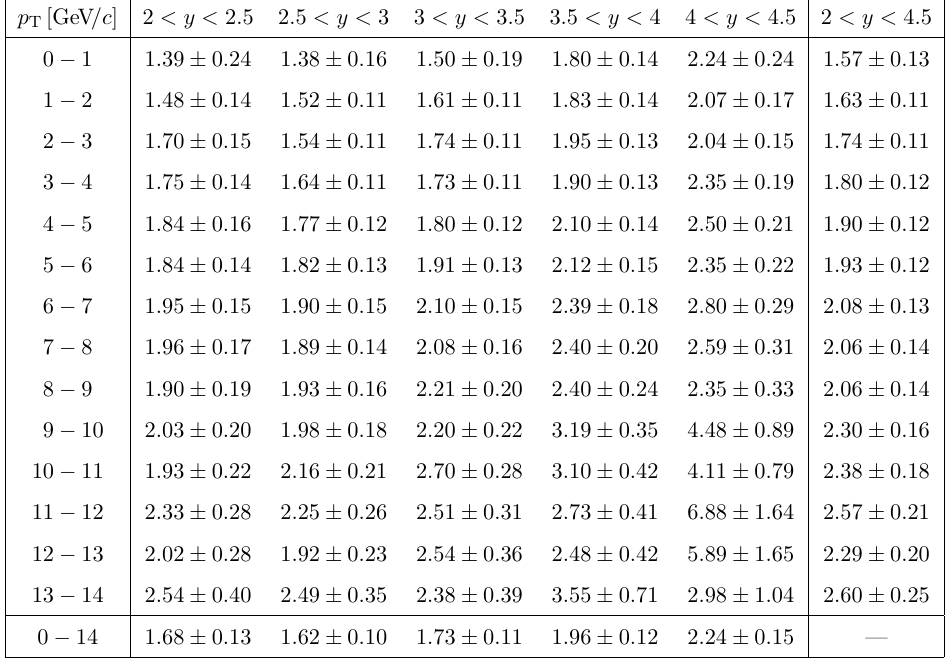
Table 10 . The ratio of cross-sections between measurements at 13 TeV and 8 TeV in di(cid:11)erent bins of p T and y for J= -from- b mesons. The systematic uncertainties are